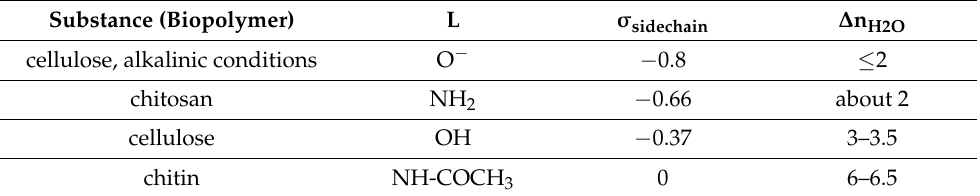
Table 3. Sidechain electron acceptor activity (Hammett ´ s constant vs. replacement of water ligands from Eu(III) by